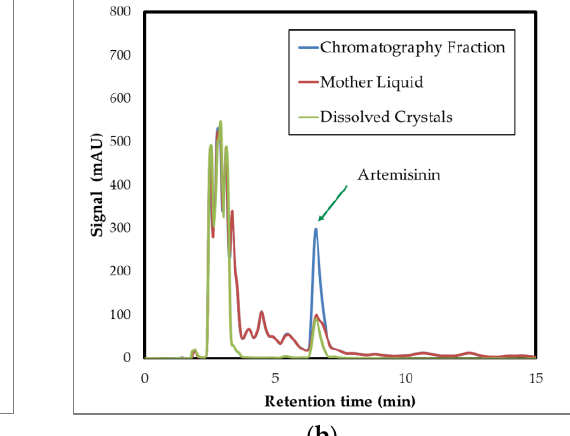
Figure 11. Possible process points for crystallization step. (SLE: Solid-liquid extraction)